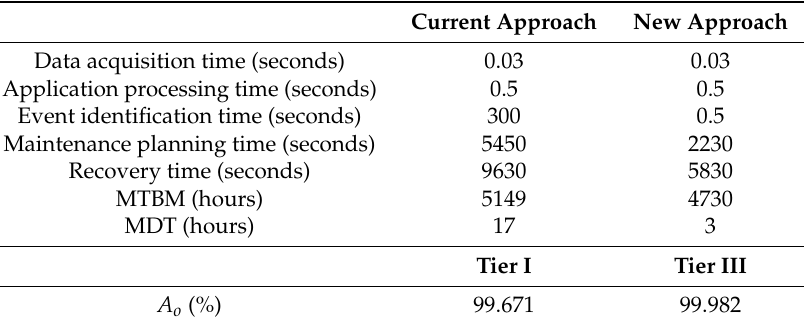
Figure 6. Time parameter presentation. Table 2. Comparison of time